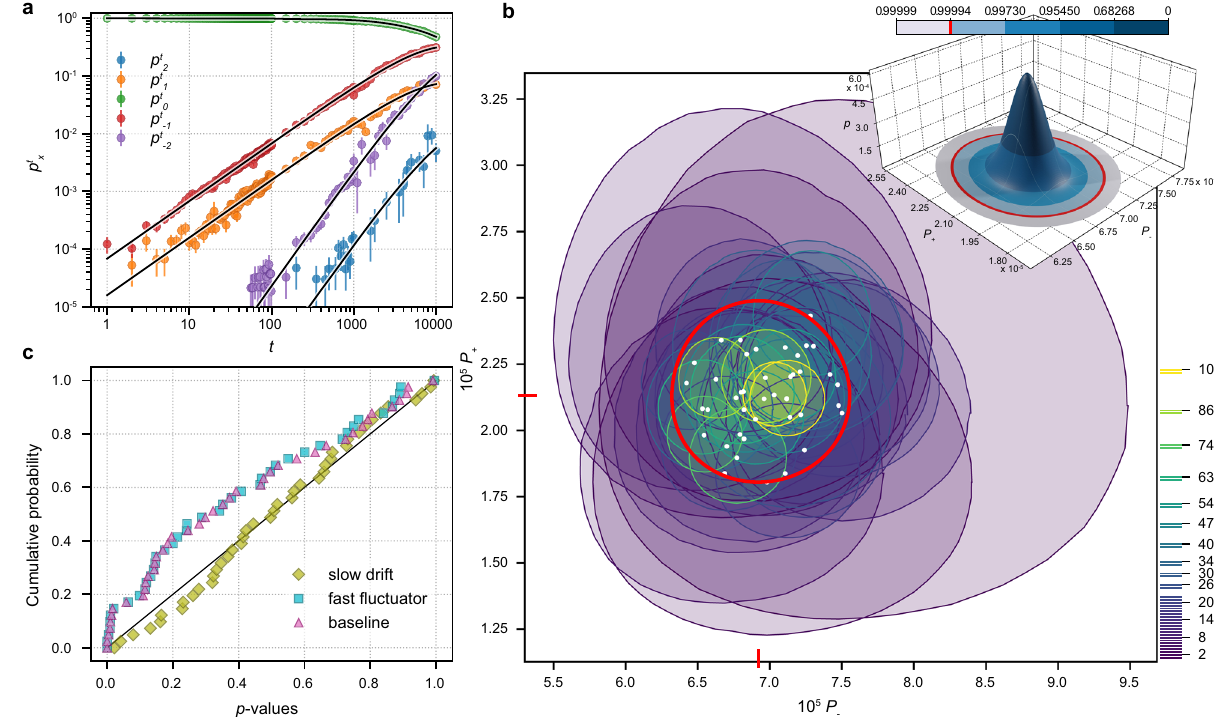
Fig. 2 Consistency of random-walk models with respect to the experimental statistics of accumulated errors. a Measured p t x for device A; error bars are given by the standard deviation of the binomial distribution, solid lines show a least-squares fi t of Eq. (1). b Likelihood-maximizing P ± (white dots) and p > 0.05 consistency regions estimated separately for each sequence length (coded by color). The inset shows the probability density function of the Dirichlet distribution with parameter α = (2.43 × 10 3 , 3.50 × 10 7 , 7.47 × 10 2 ). The corresponding global best- fi t values for P ± are marked by red lines on the axes of the consistency-region plot. The color scale indicates the level of con fi dence at different coverage factors k for a symmetric normal distribution; the red circle in both plots and the marker in the color scale indicates the region corresponding to k = 4. c Empirical cumulative distribution of p -values for different models in comparison to the uniform distribution (black